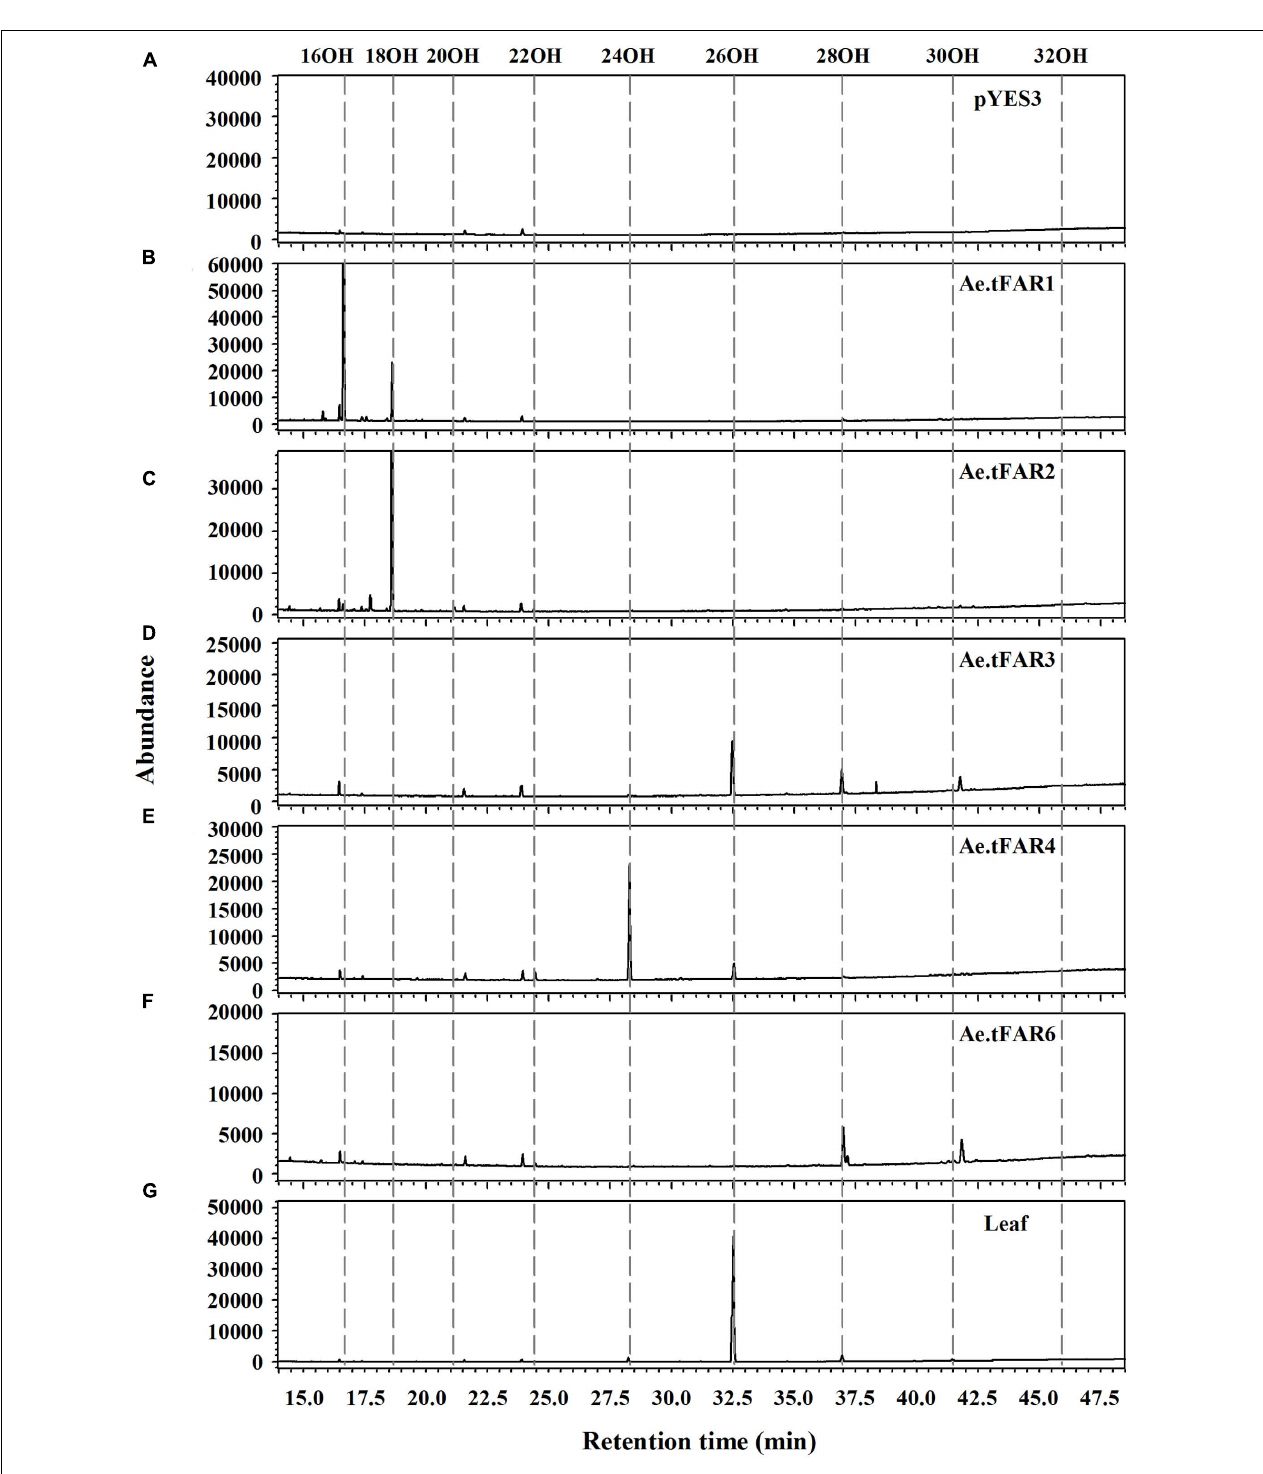
FIGURE 5 | Heterologous expression of the five Ae.tFARs in yeast mutant INVSur4#. The yeast expressing (A) empty vector control pYES3 or vector harboring (B) Ae.tFAR1 (C) Ae.tFAR2 , (D) Ae.tFAR3 , (E) Ae.tFAR4 or (F) Ae.tFAR6 . Transgenic yeast cells were grown in stringent medium lacking tryptophan and uracil. Primary alcohols were separated from other neutral lipids by thin layer chromatography (TLC). In empty vector control, no primary alcohols were detected. (G) All primary alcohols in transgenic yeast were also observed in the leaf blades of Ae. tauschii .